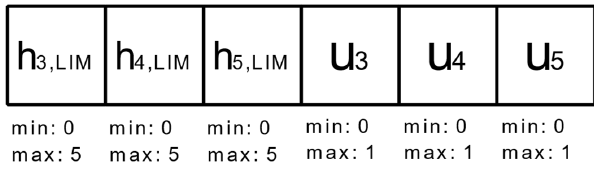
Figure 10. Chromosomal structure in strategy #2.